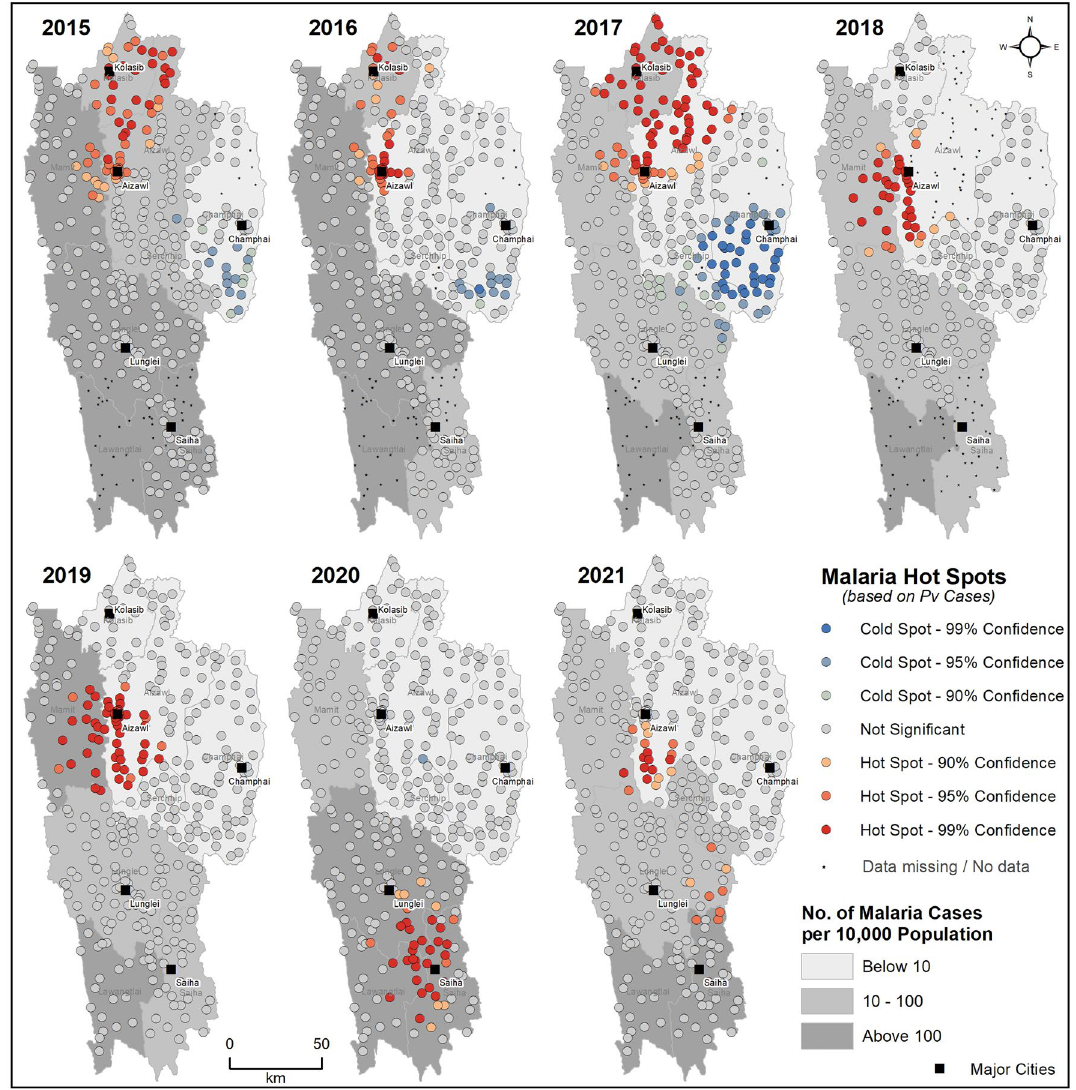
Figure 5. Space–time trends of Pv malaria hotspots from 2015 to 2021 in Mizoram. The map was created using licensed version of ArcGIS 10.4 software by Esri. For more information about Esri software, please visit www. esri.